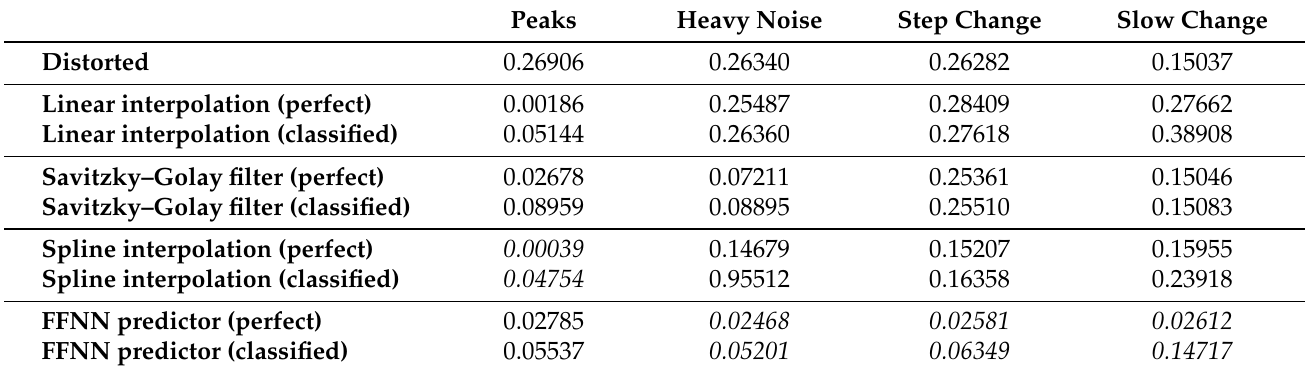
Table 4. RMSE after reconstruction with different methods (with perfect and algorithmic artifact classifications) for the mocap sequence with a 10% distorted time in the sequence.